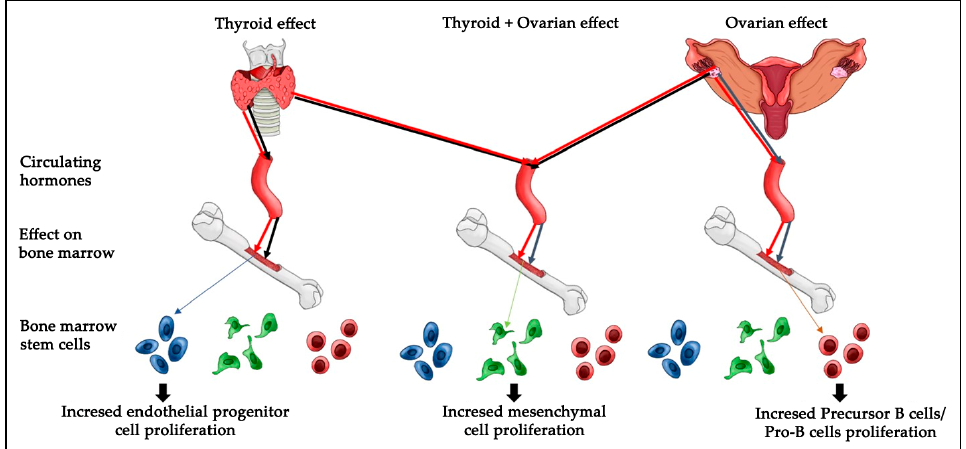
Figure 7. Proposed model of ovarian or/and thyroid hormonal effects on bone marrow stem cells. Ovariectomy leads to increased Pro-B cell proliferation (black arrows). Thyroidectomy leads to increased endothelial progenitor cell proliferation (black arrows). The removal of the ovaries and thyroid leads to increased mesenchymal cell proliferation (black arrows). Black arrows illustrate the hormonal loss and its effect on cell proliferation. Red arrows indicate the normal hormonal situation (no effect on normal cell proliferation).